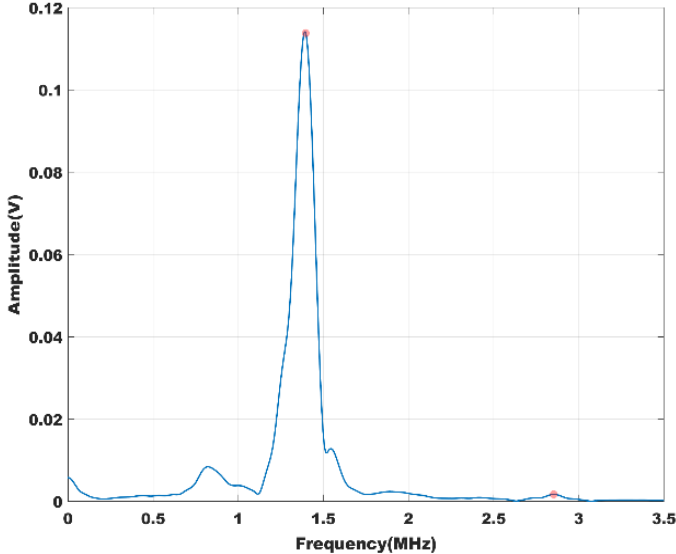
Figure 8. The received signal for Fourier spectra of the fundamental and second harmonic signal.